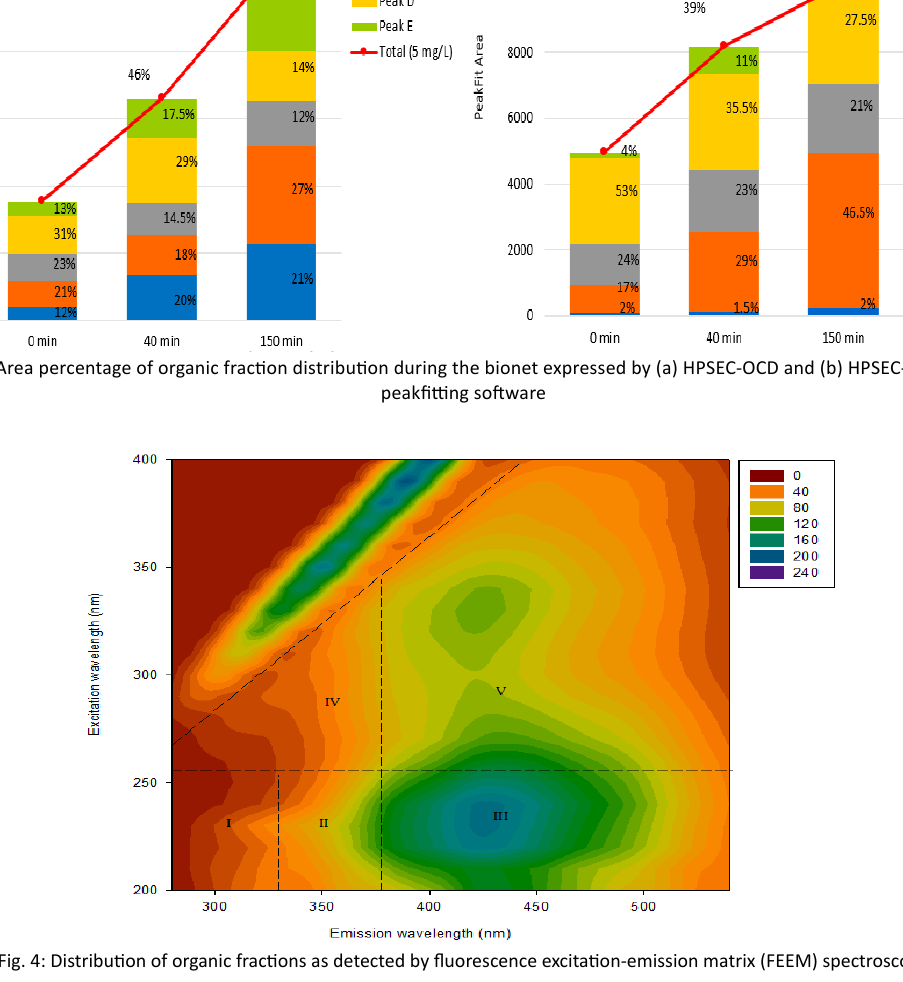
Fig. 4: Distribution of organic fractions as detected by fluorescence excitation-emission matrix (FEEM)